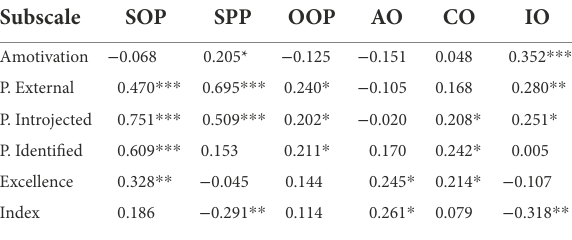
TABLE 4 Correlations between the MPSES and the HF-MPS and GOCS, Study 1b. Subscale